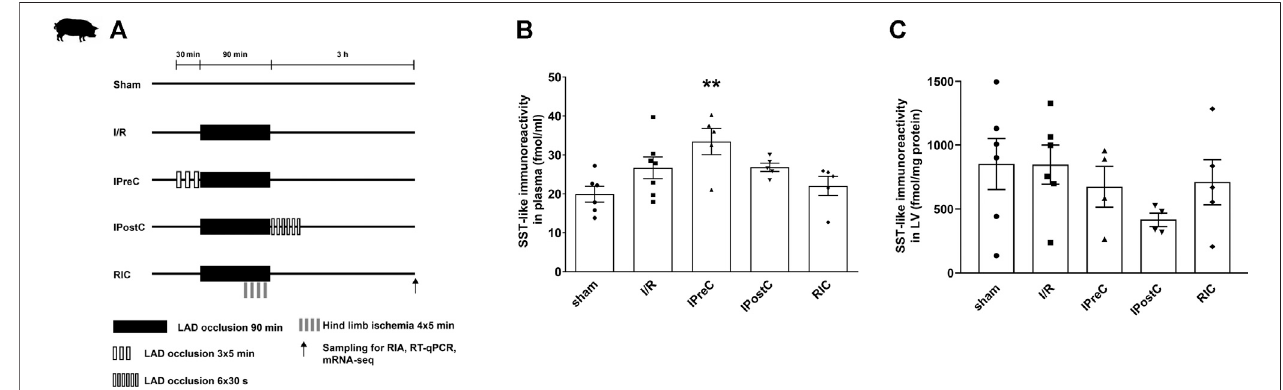
FIGURE 3 | Closed-chest porcine acute myocardial infarction study protocol (A) . Somatostatin-like immunoreactivity of plasma (B) and left ventricular samples (C) . Data are presented as mean ± SEM. ** p < 0.01 vs. sham (n (cid:2) 6), one-way ANOVA, Tukey post hoc test, I/R: ischemia-reperfusion (n (cid:2) 7 in plasma and 6 in LV), IPreC: ischemic preconditioning (n (cid:2) 5 in plasma and 4 in LV), IPostC: ischemic postconditioning (n (cid:2) 5 in plasma and 4 in LV), RIC: remote ischemic conditioning (both n (cid:2) 5), LAD: left anterior descending coronary artery, and LV: left